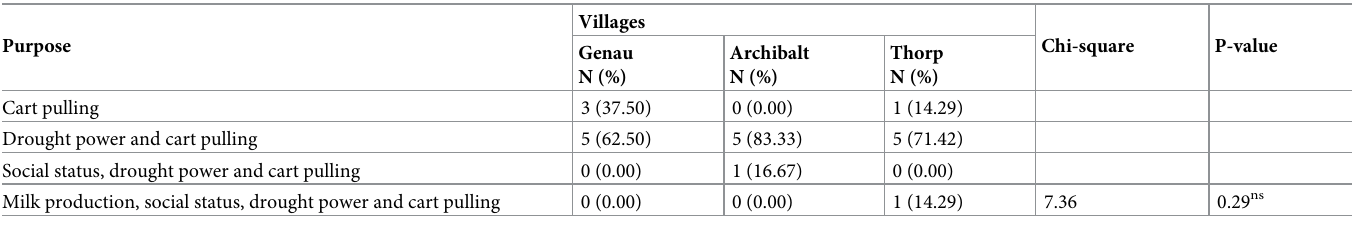
Table 2. Purpose of keeping donkeys.